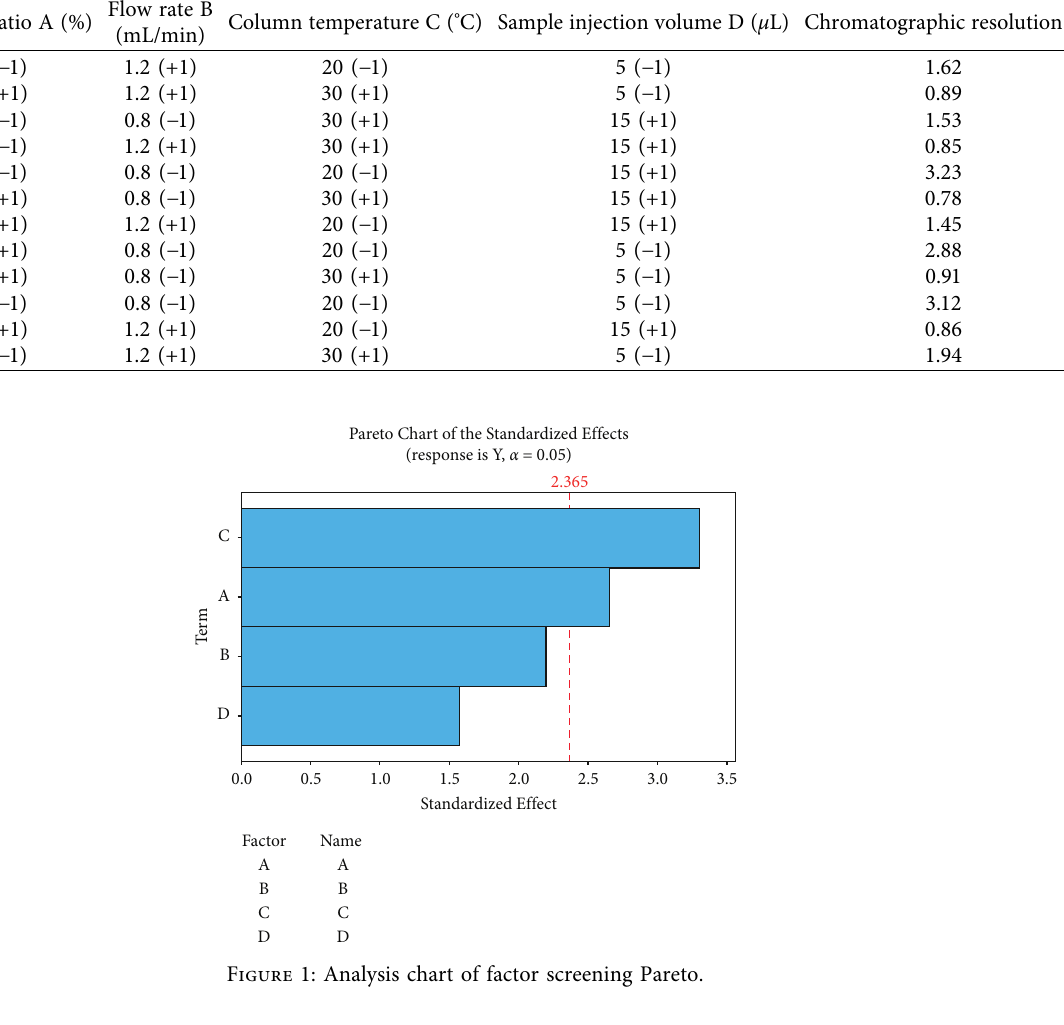
Table 1: PBD experimental program and results.